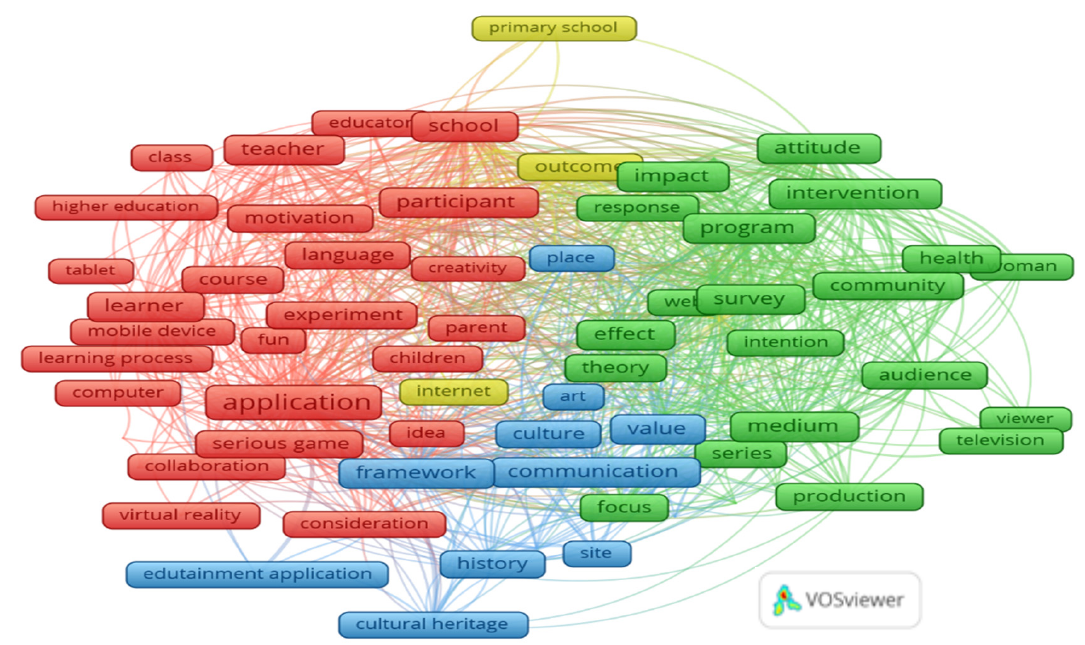
Figure 3. Themes from edutainment 2017–2021. Source: Web of science using VOSviewer.